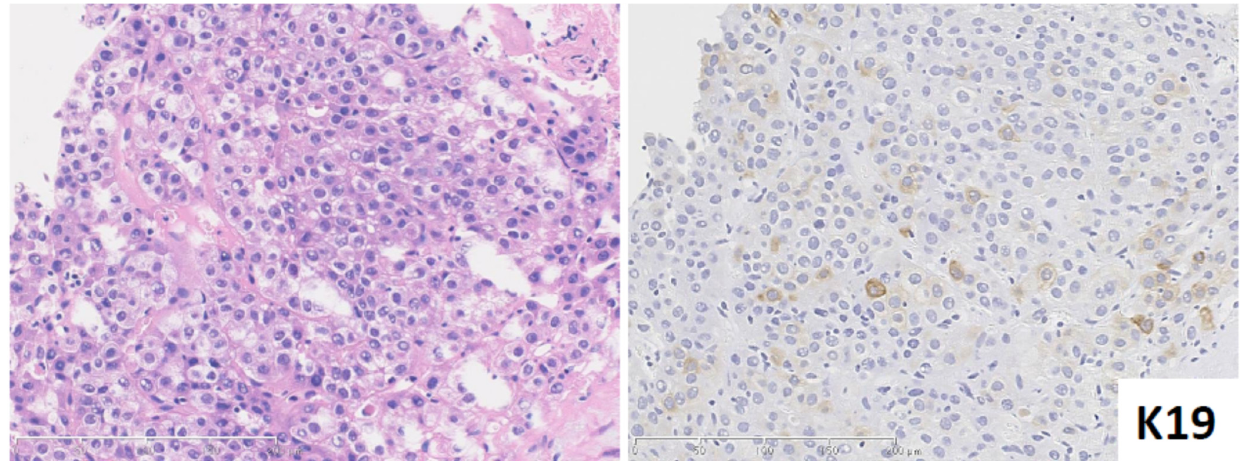
Figure 2. Keratin (K) 19 positive HCC. HCC shows moderate differentiation with no sign of glandular feature. K19 immunohistochemistry shows weak membranous and/or cytoplasmic positivity in the tumoral cells. ( Left ) hematoxylin and eosin staining; ( Right ) K19 immunohistochemistry.